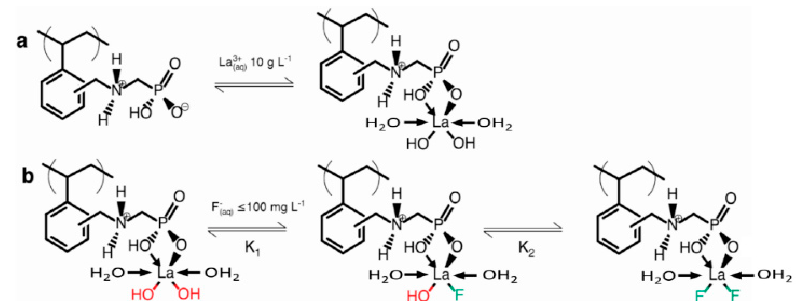
Figure 1. Sorbent resin chemistry . ( a ) Activation of Puromet TM MTS9501 resin with trivalent metal (for example, La) for later fluoride uptake. ( b ) Ligand exchange (F − for OH − ) when La-activated Puromet TM comes in contact with aqueous F − (e.g., from NaF) based on [18]. Note: The full La inner coordination sphere is not shown for reasons of space.